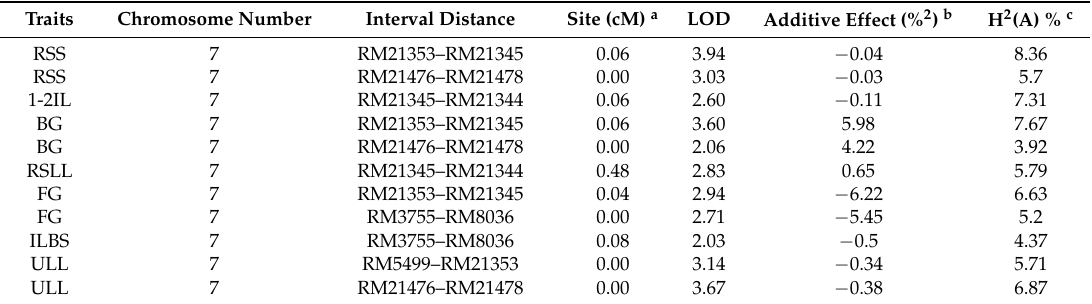
Table 5. Marker intervals, locus distance (cM), log of odd (LOD) score, additive effect in terms of percentage for the QTLs identified on chromosome no. 7 governing rice traits associated with cold tolerance including, RSS, 1-2 IL, BG, RSLL, FG, ILBS, and ULL at the booting stage of